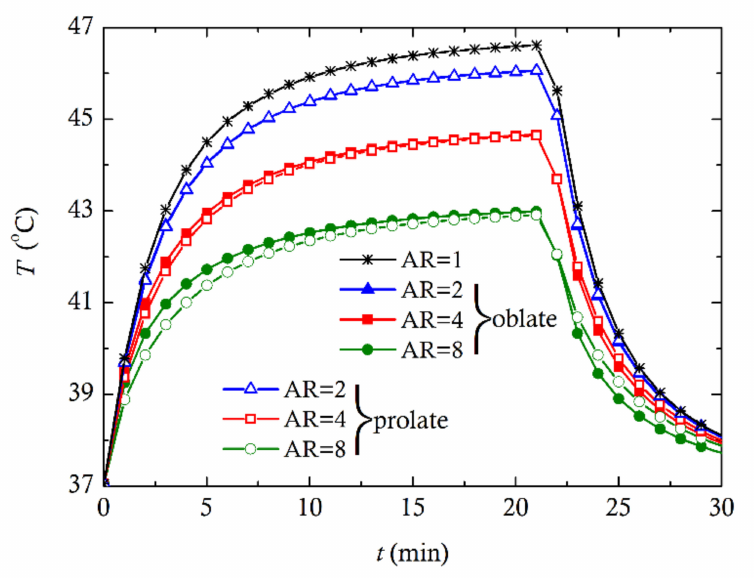
Figure 7. Behavior of temperature profiles at the tumor center over time for all analyzed